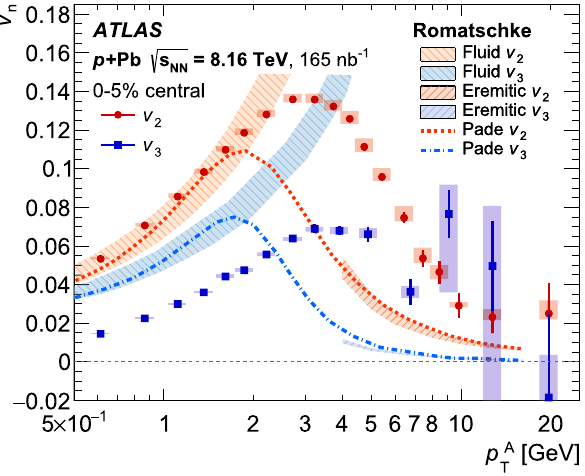
Fig. 7 Coefficients v 2 and v 3 plotted as a function of p T for central 0–5% p +Pb collisions from the MBT event sample. Theoretical calcu- lations relevant to the low- p T regime from hydrodynamics and to the high- p T regime from an ‘eremitic’ framework from Romatschke [26] are also shown. The lines are Padé-type fits connecting the two regimes, where the red dotted line is for v 2 and the blue dash-dotted line is for v 3 . Statisticaluncertaintiesareshownasnarrowverticallinesoneachpoint, and systematic uncertainties are presented as coloured boxes behind the